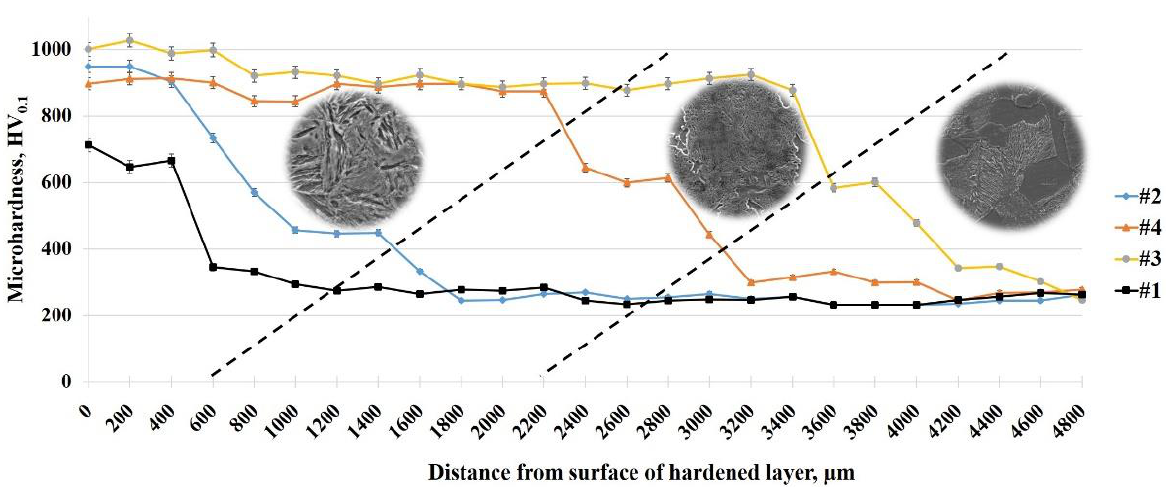
Figure 7. The distribution of microhardness over the depth of the cross-section of steel 30CrMnSiA under different modes of thermal cycling.